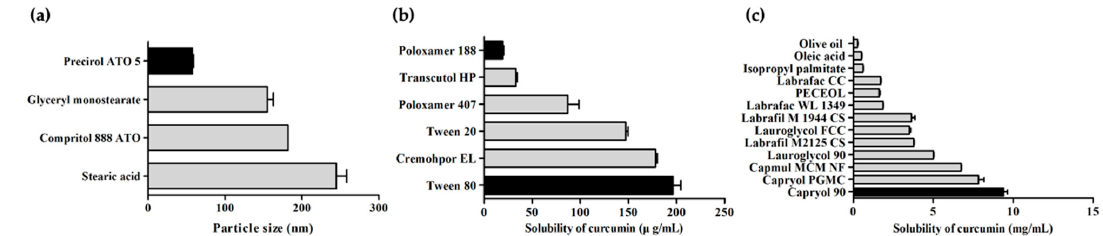
Figure 1. Particle size of solid lipid nanoparticles prepared with various solid lipids ( a ); solubility of curcumin in various liquid lipids ( b ) and 1% surfactant solutions ( c ). The data are shown as mean ± SD ( n = 3).